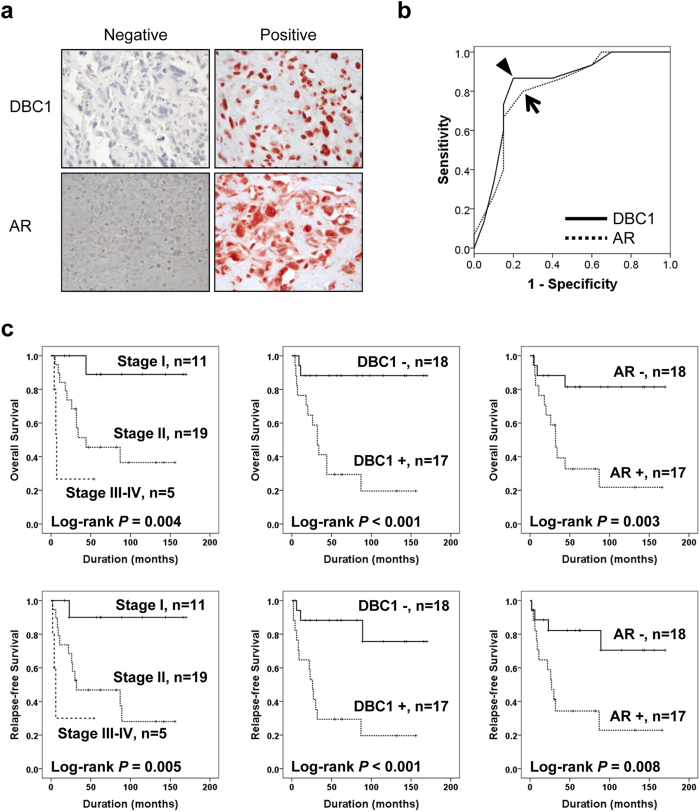
Immunohistochemical expression of DBC1 and AR in human osteosarcoma tissue and Kaplan-Meier survival analysis in 35 osteosarcoma patients.(a) DBC1 is expressed in the nuclei of osteosarcoma cells and AR is expressed both in the nuclei and cytoplasm of osteosarcoma cells. (b) Statistical analysis of the sensitivity and specificity of the DBC1 and AR immunohistochemical staining scores for the death of the patient (event of overall survival) by receiver operator characteristic curves. The arrow head indicate the cut-off point for the immunohistochemical staining score of DBC1 and an arrow indicates the cut-off point for AR immunostaining. (c) Overall survival and relapse-free survival are shown according to the tumor stage, DBC1 expression, and AR expression.